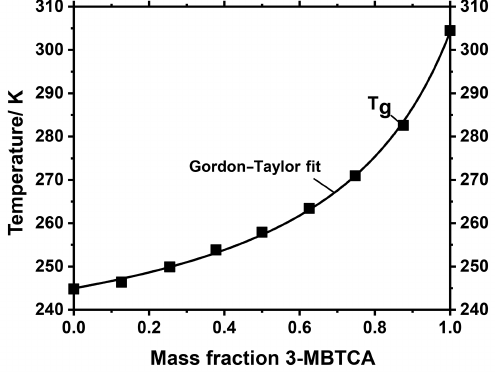
Figure 8. Glass transition temperatures (points) of spray-dried mix- tures of rac -(2 R ,3 S) -tetraol and 3-MBTCA. The black line repre- sents the Gordon–Taylor fit to the